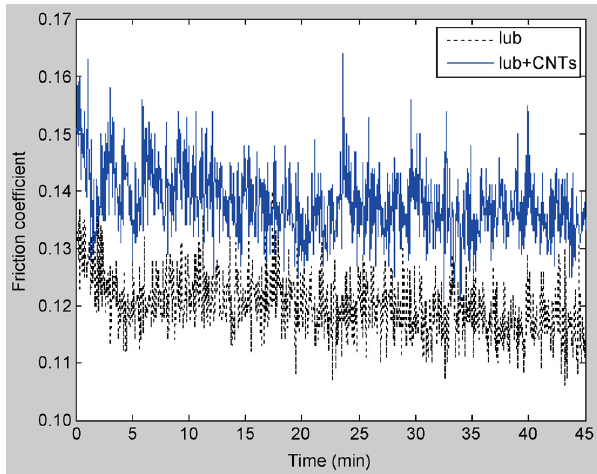
Fig. 5 Friction coefficient with or without CNTs under lubricated condition.